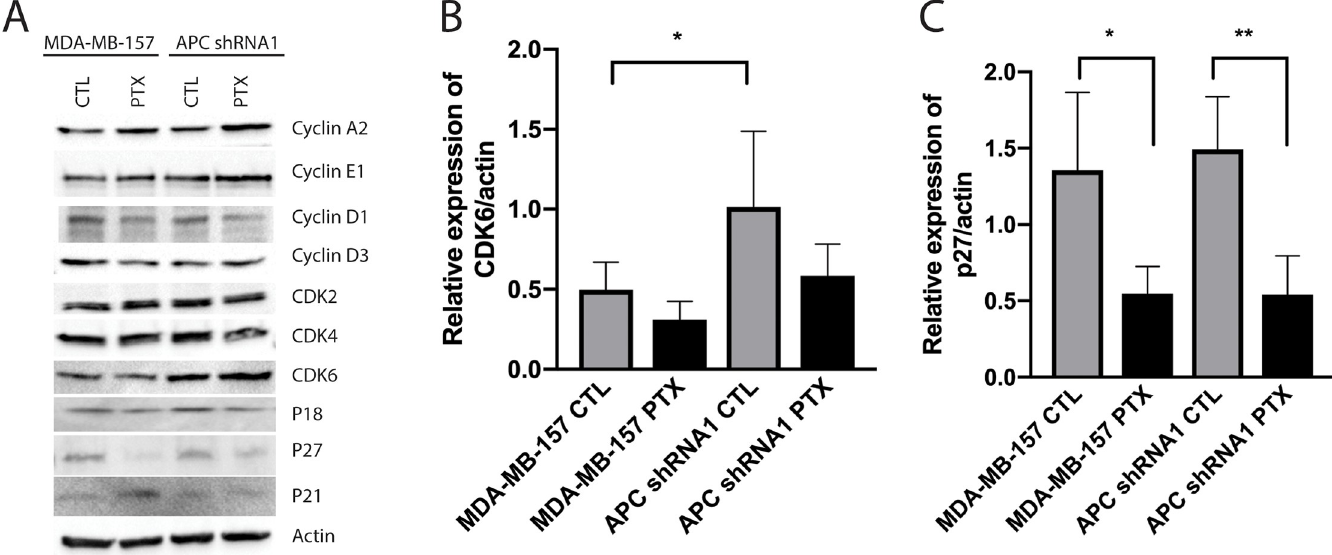
Fig 4. Western blot analysis of canonical cell cycle proteins. Untreated or PTX treated lysates were probed for expression of canonical cell cycle proteins. (A) Representative western blots are shown for cyclin A2, cyclin E1, cyclin D1, cyclin D3, CDK2, CDK4, CDK6, p18, p21, and p27. Actin was used as a loading control. (B-C) Bar graph of protein expression quantification in treated and untreated MDA-MB-157 and APC shRNA1 cell lines is shown (n = 3). (B) Analysis indicated that loss of APC resulted in a significant increase in CDK6 expression. � p < 0.05 compared to parental cells. (C) P27 expression decreased upon PTX treatment in both MDA-MB-157 and APC shRNA1 cells. � p < 0.05, �� p < 0.01 compared to control treated cells of the same genotype. No change was seen in the remaining proteins.